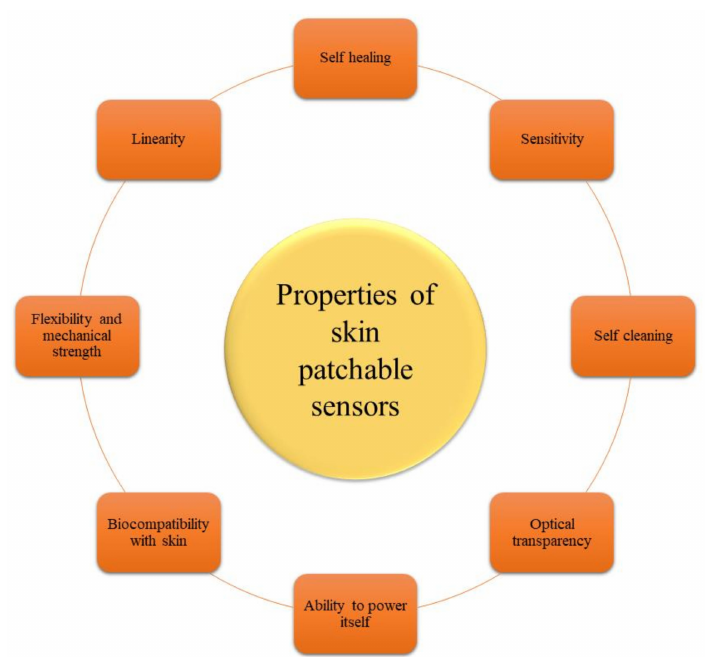
Figure 14. Skin-patchable sensors have a number of desirable